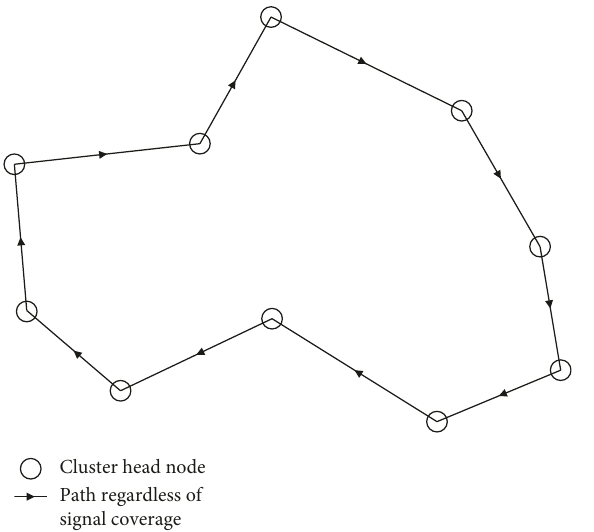
Figure 3: An example of path planning with ant colony algorithm regardless of signal range.